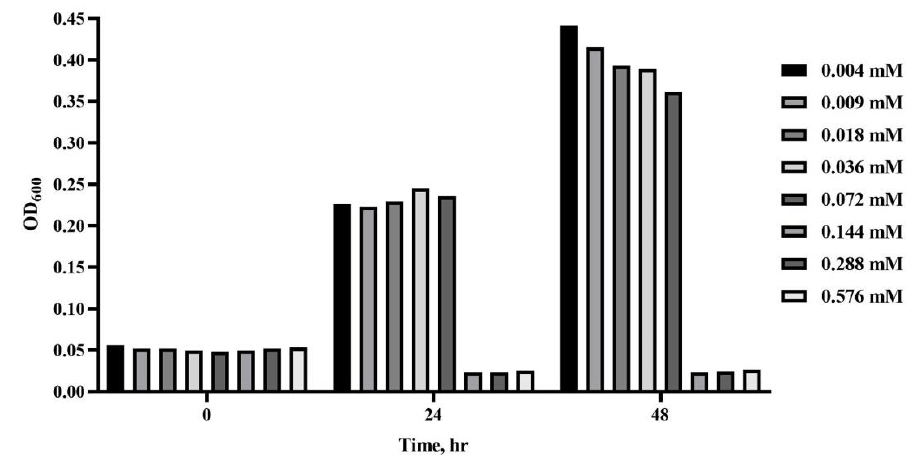
Figure 2. MIC test results for farnesol in the treatment of C. acnes -induced acne after 24 and 48 h incubations. The MIC was measured by assessing the effects of a series of farnesol concentrations (from 0.004 to 0.576 mM) on the absorbance at 600 nm (OD 600 ). The MIC was determined as 0.14 mM.